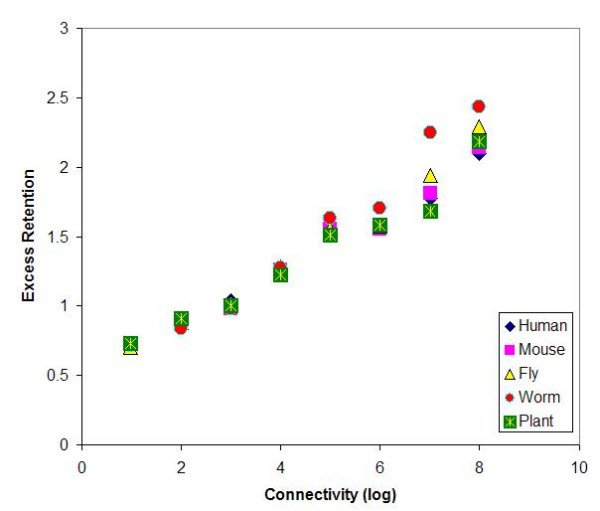
Evolutionary Excess Retention and Connectivity. The relationship between connectivity and excess retention (age) of a protein ρ: 0.98301. Proteins were binned on a log scale and the propensities of each bin possessing orthologs in several other species was calculated. Proteins that participate in more interactions tend to be older.